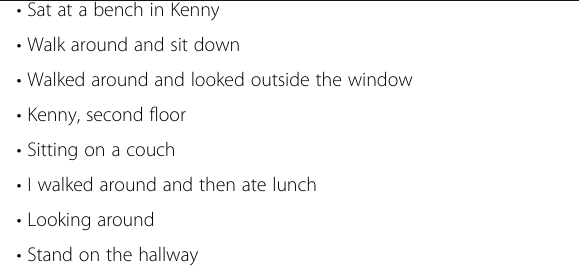
Table 3 Free-form responses to end-of-study questionnaire Question 1 ( “ What did you do while listening to the audio- book? ” ) (Continued) (cid:129) Sat at a bench in